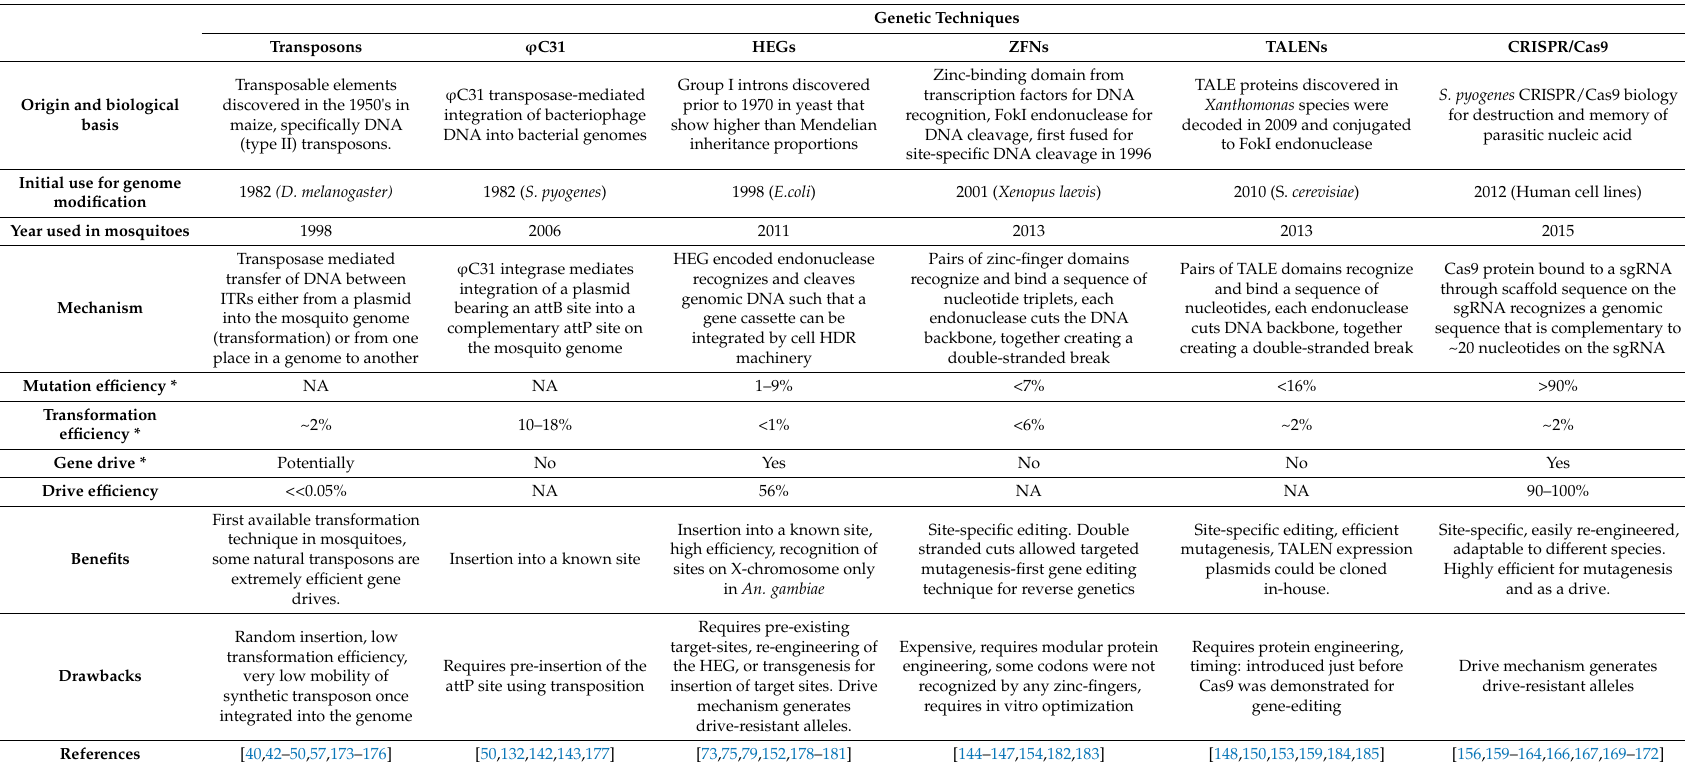
Table 1. Comparison of genetic techniques and their application to mosquito genetic manipulation and gene